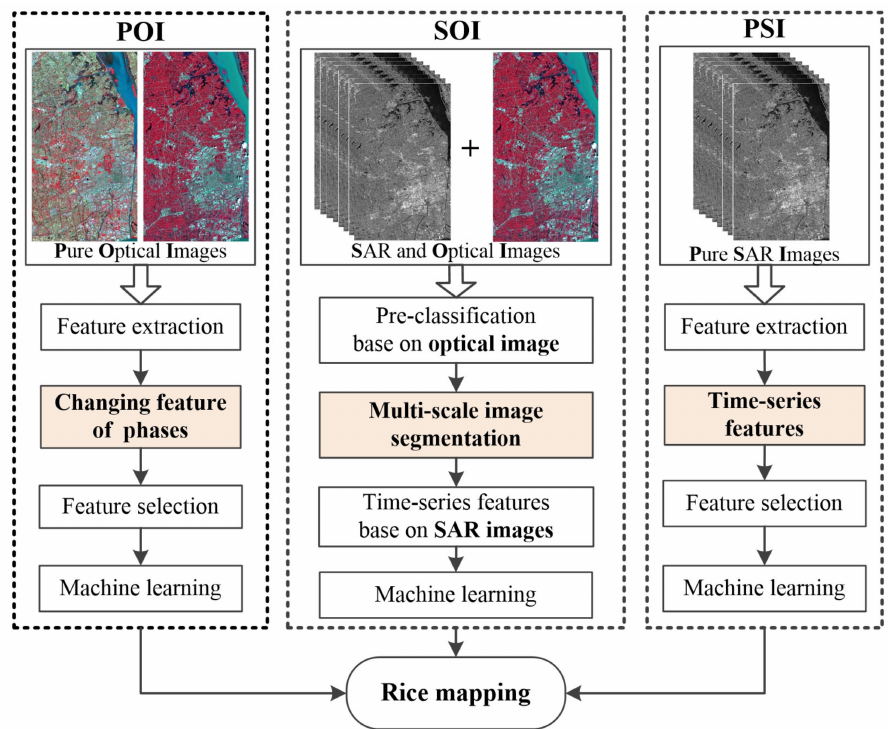
Figure 5. A comparison of different strategies for rice